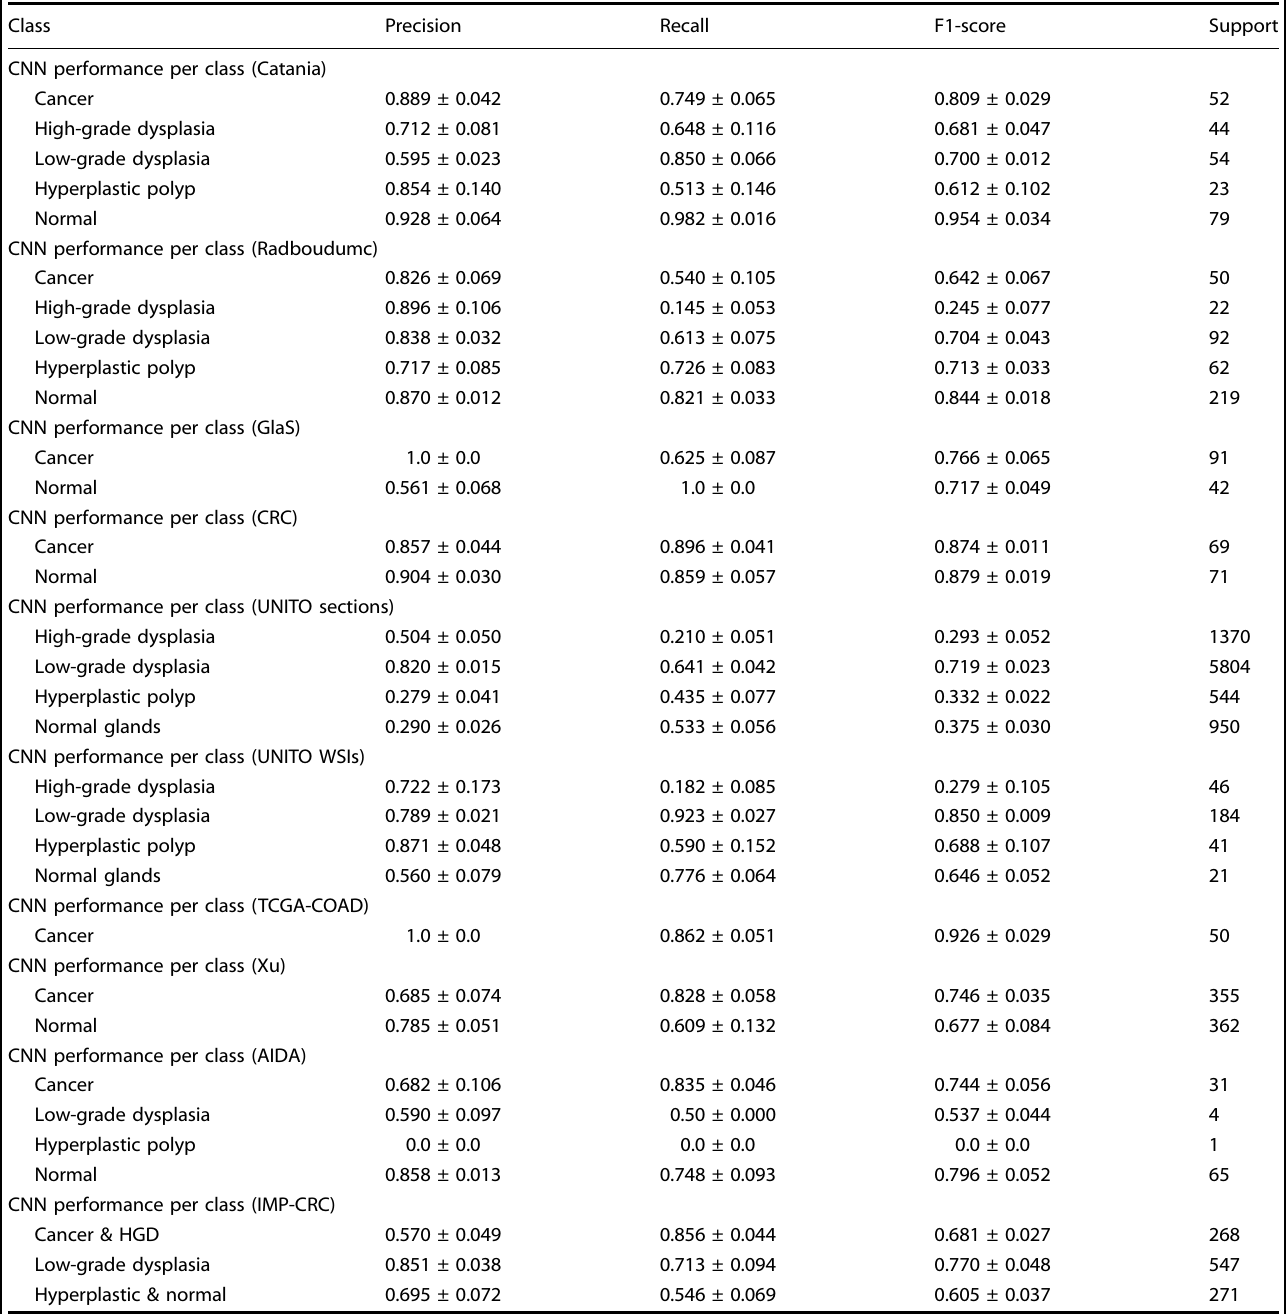
Table 8. Overview of CNN performance, reporting the precision, the recall and the F1-score of the single classes for image-level classi fi cation, in both Catania and the publicly available